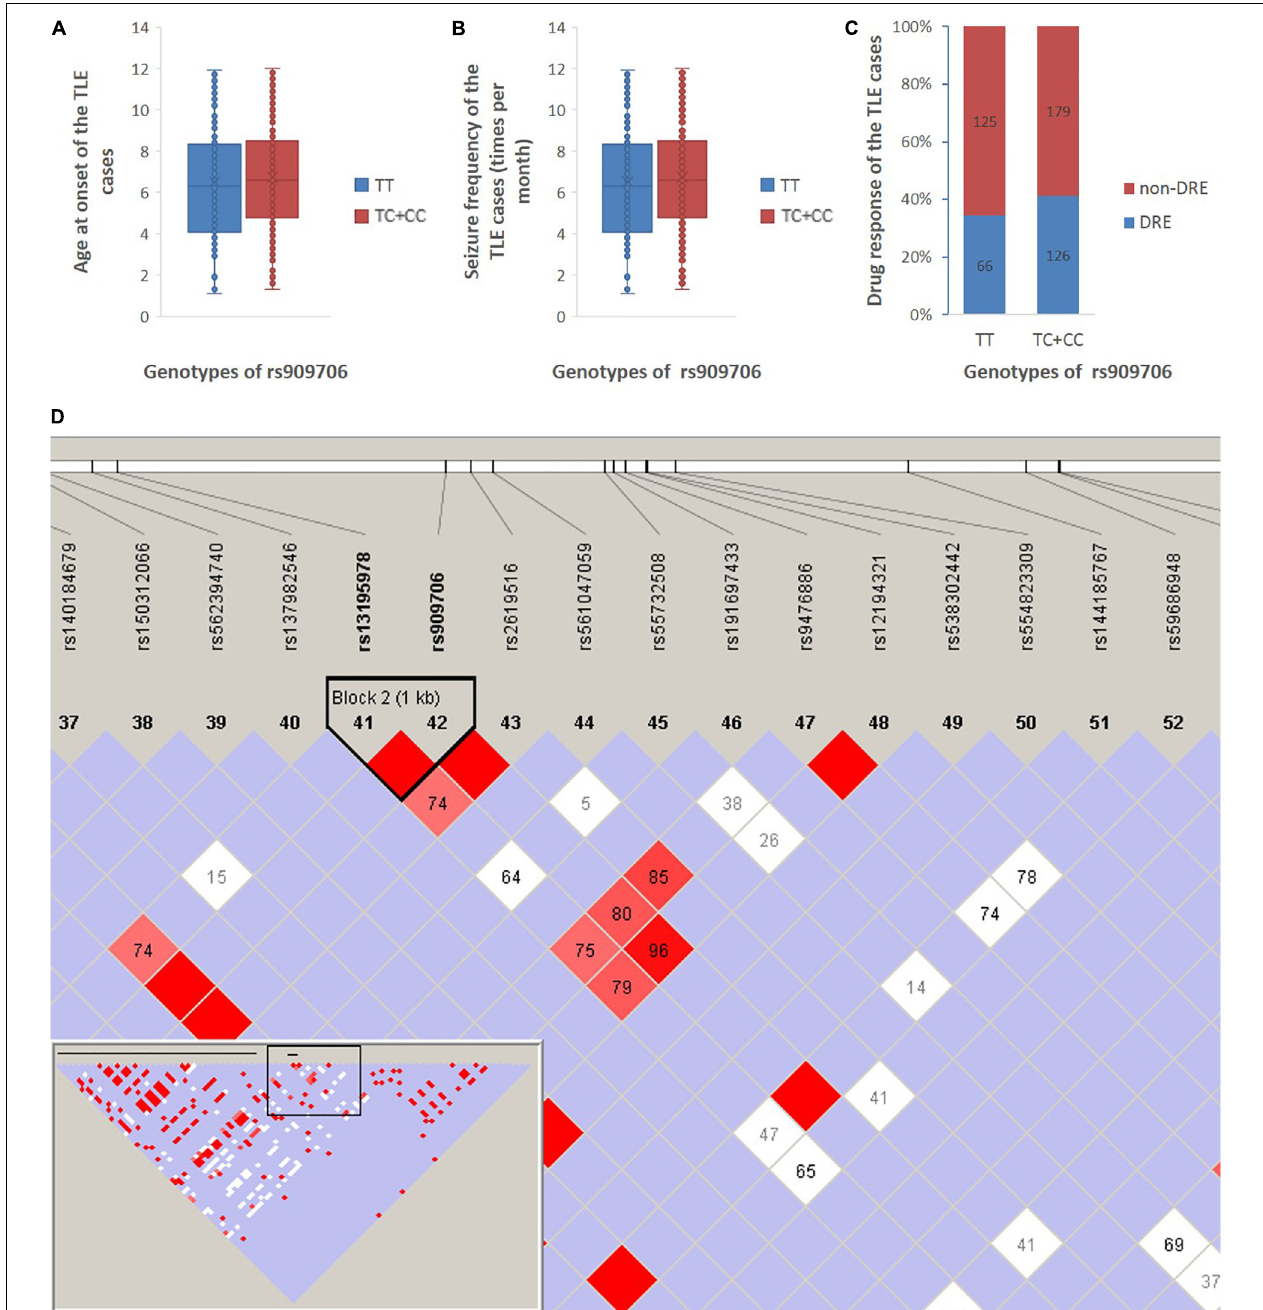
FIGURE 1 | Age at onset, seizure frequency, and drug response between the TT genotype and the TC + CC genotypes in all TLE patients in cohort 1 + 2. (A) The age at onset of the TLE patients was 22 ± 16 and 20 ± 13 years among those with the TT genotype and the TC + CC genotypes, respectively. (B) Seizure frequency of patients with the TT genotype and the TC + CC genotypes was 6.5 ± 2.7 and 6.7 ± 2.6 per month, respectively. (C) Drug-resistant incidence of patients with the TT genotype and the TC + CC genotypes was 34.4 and 41.1%, respectively. (D) According to the 1,000 Genomes Project, SNPs are downloaded between 10,000 nucleotides downstream and 10,000 nucleotides upstream of the rs909706 locus (Chromosome 6, NC_000006.11 (15650871..15670871), and according to the analysis using Haploview 4.2, only rs13195978 was observed to be in LD with rs909706 ( D ’ =